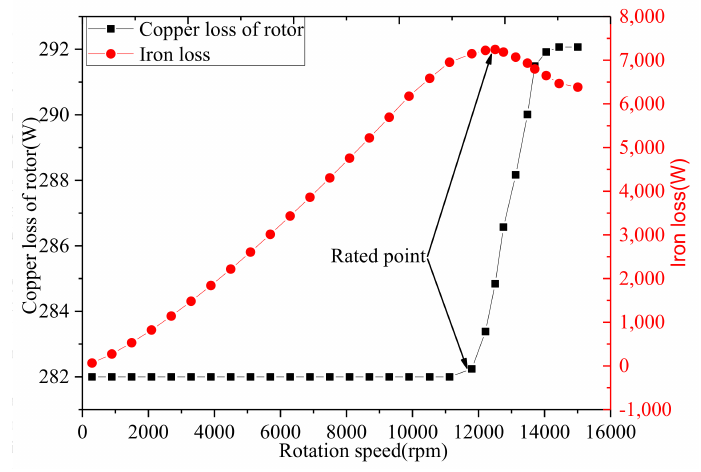
Figure 13. The curves of rotor copper consumption and stator iron consumption vs rotation